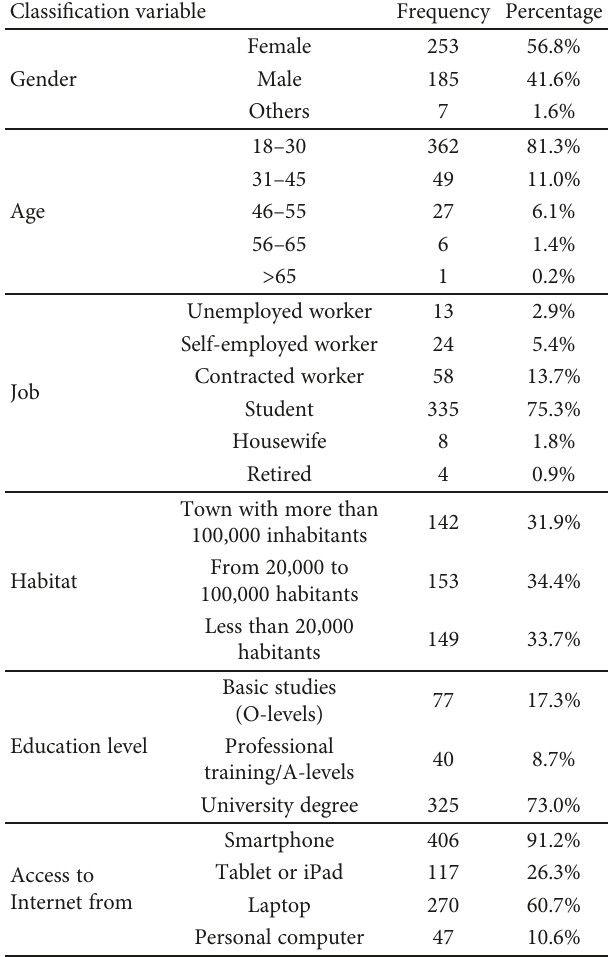
Table 2: Demographic characteristics of the sample ( n = 445